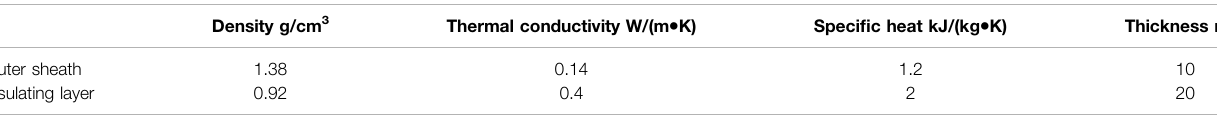
TABLE 1 | Thermal performance parameters of cable materials.